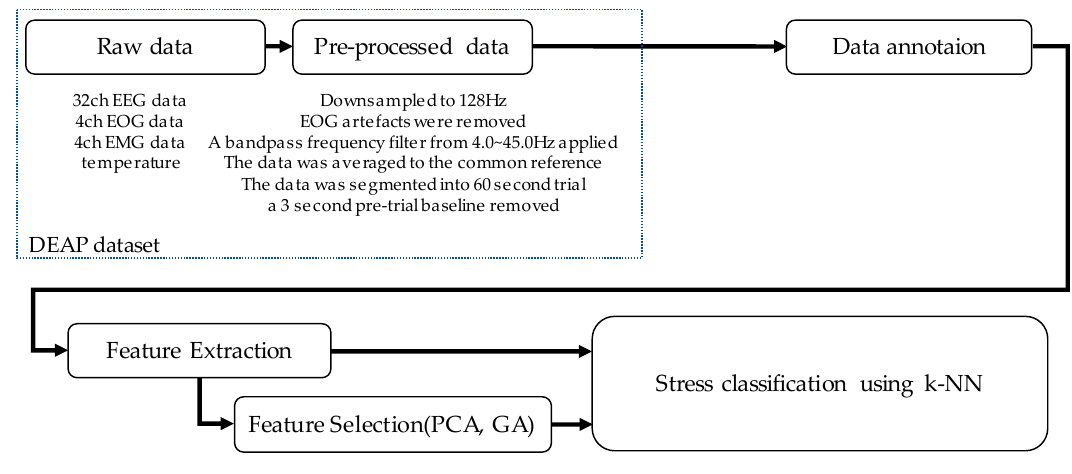
Figure 1. An overall process of stress classification.